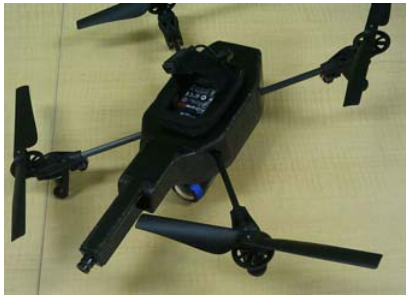
Figure 2. AR.Drone 2 UAV system with ION Air Pro